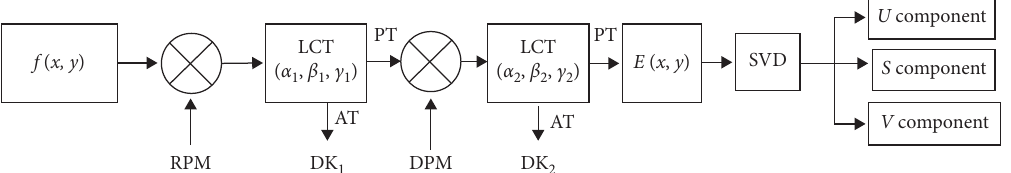
Figure 3: Flow chart for the encryption